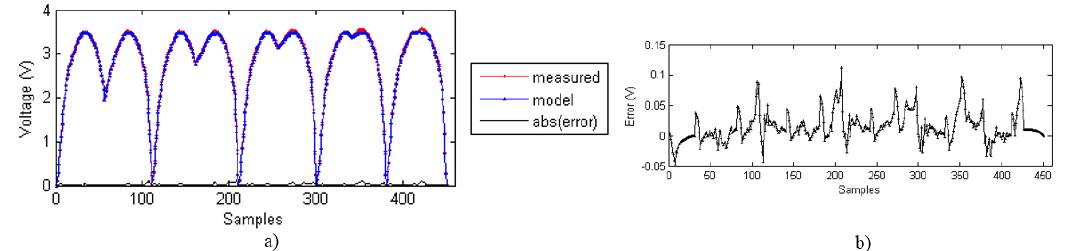
Figure 11. ( a ) Measured data, ELAM model and absolute value of the error; ( b ) Error zoom.